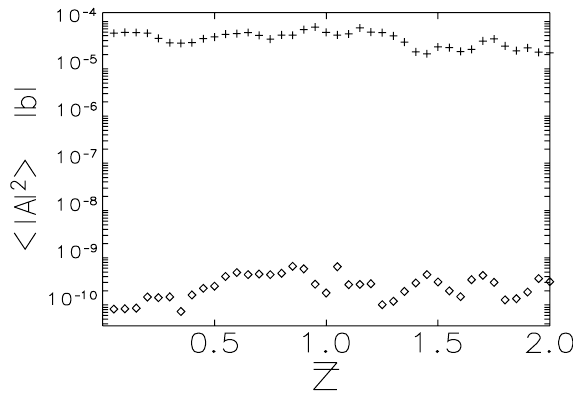
FIG. 9. The filtered scaled average radiation intensity hj A j 2 i ( (cid:1) ) and modulus of the bunching parameter j b j (+) over the < 9 : 05 of a Gaussian profile single period interval 8 : 95 < (cid:9) zz 1 (cid:1) 18 and (cid:18) (cid:1) 3 . electron pulse of (cid:9) ll e e